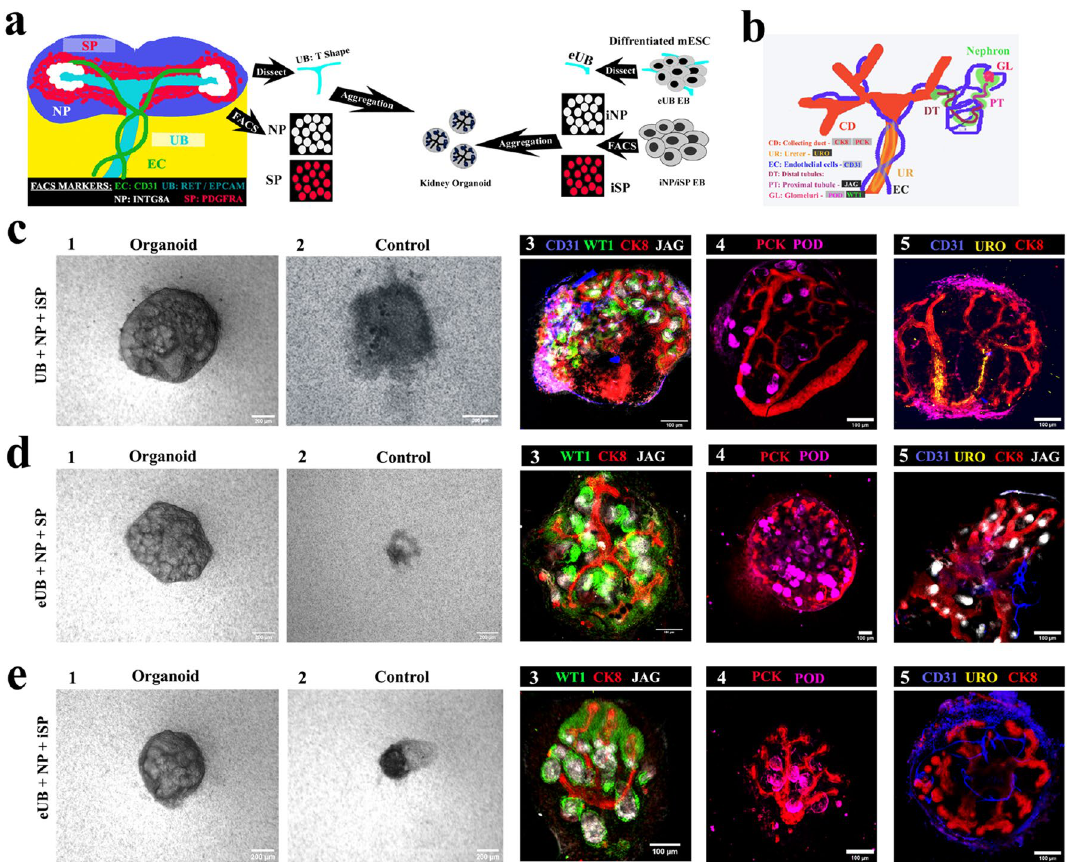
Figure 5. Testing mESC-derived components in chimaeric organoids. ( a ) Schematic of the experiment. ( b ) Schematic summary of natural expression of markers used in C-E. ( c ) Chimaeric organoids formed by aggregating whole UB (T shape) with sorted nephron progenitor (NP) and induced stromal cells (iSP) [UB + NP + iSP]. ( d ) Chimeric organoids formed by aggregating eUB with sorted nephron progenitor (NP) and induced stromal cells (SP) [eUB + NP + SP]. ( e ) Chimeric organoids formed by aggregating eUB with sorted nephron progenitor (NP) and induced stromal cells (iSP) [eUB + NP + iSP]. Representative bright field (first two images) and immunostaining images are shown. In all cases the ureteric bud (UB/eUB) arborized and all other components developed, but only the UB formed a ureter-type exit tube extending beyond the kidney (c4). Controls are aggregates without either eUB or UB. Scale bar, 200 µm for bright field images and 100 µm for fluorescence images. Abbreviations: CD31: platelet endothelial cell adhesion molecule, CK8: cytokeratin 8, WTI: Wilms tumor 1, JAG: jagged1, PCK: pan-cytokeratin, POD: podocalyxin, URO: uroplakin. Images are representative of at least three different Separate testing of eUB and iSP cells in combination with embryo-derived components. As